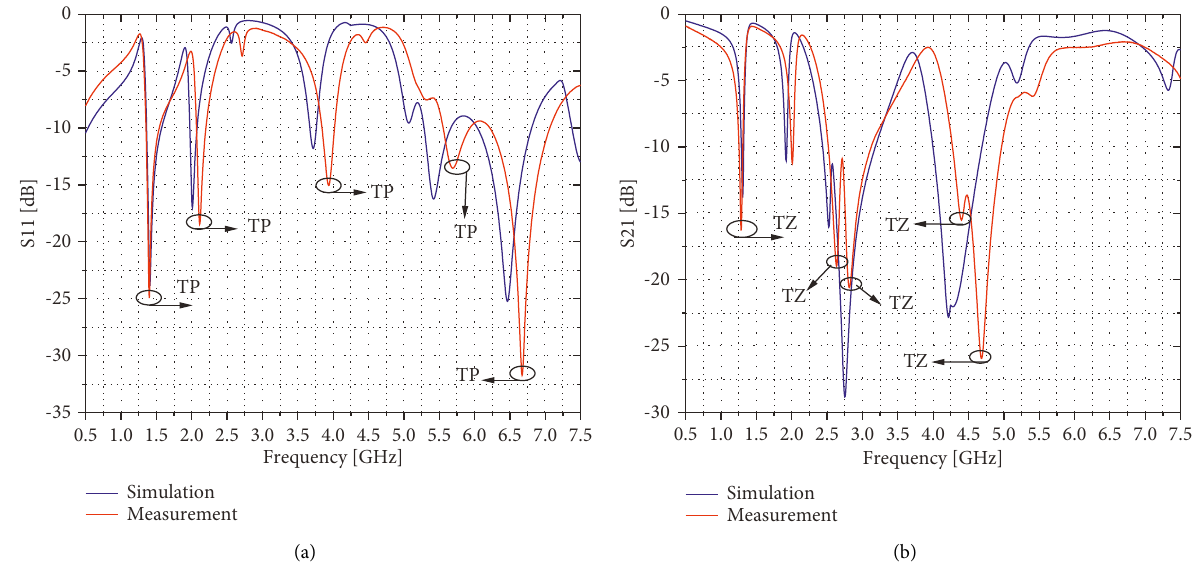
Figure 9: Simulated and measured reflection and transmission coefficients of the proposed quadband filter: (a) reflection coefficient; (b) transmission coefficient.